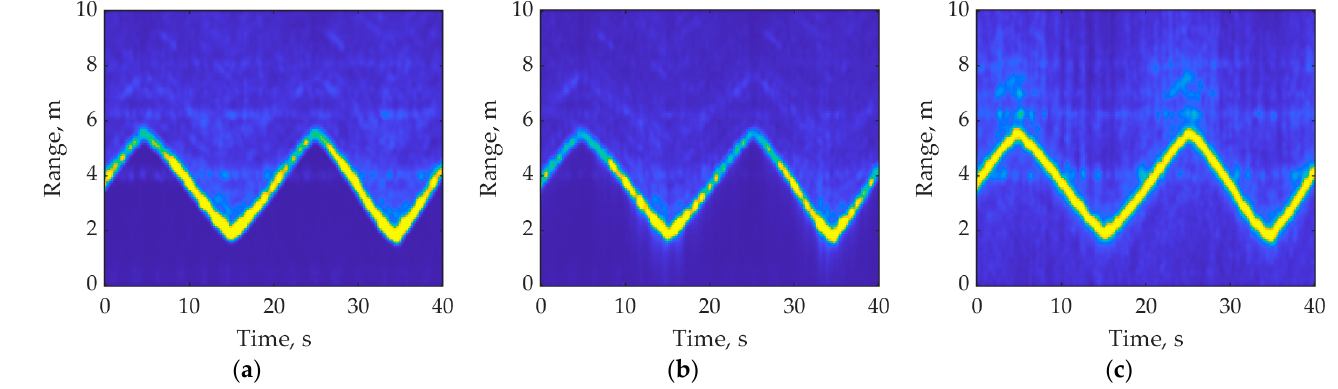
Figure 9. The results of the work of the inter-periodic subtraction algorithm ( a ), local variance algorithm ( b ) and difference samples normalization algorithm ( c ). The warmer tones correspond to more intensive reflection.